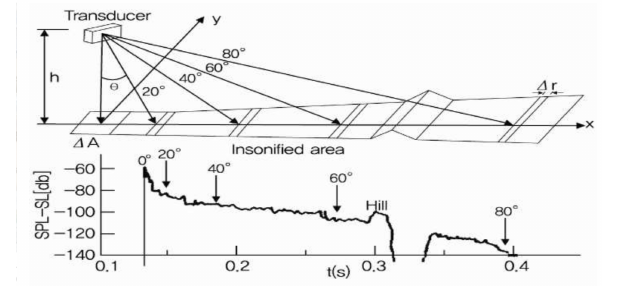
Figure 2. Imaging technique of SSS